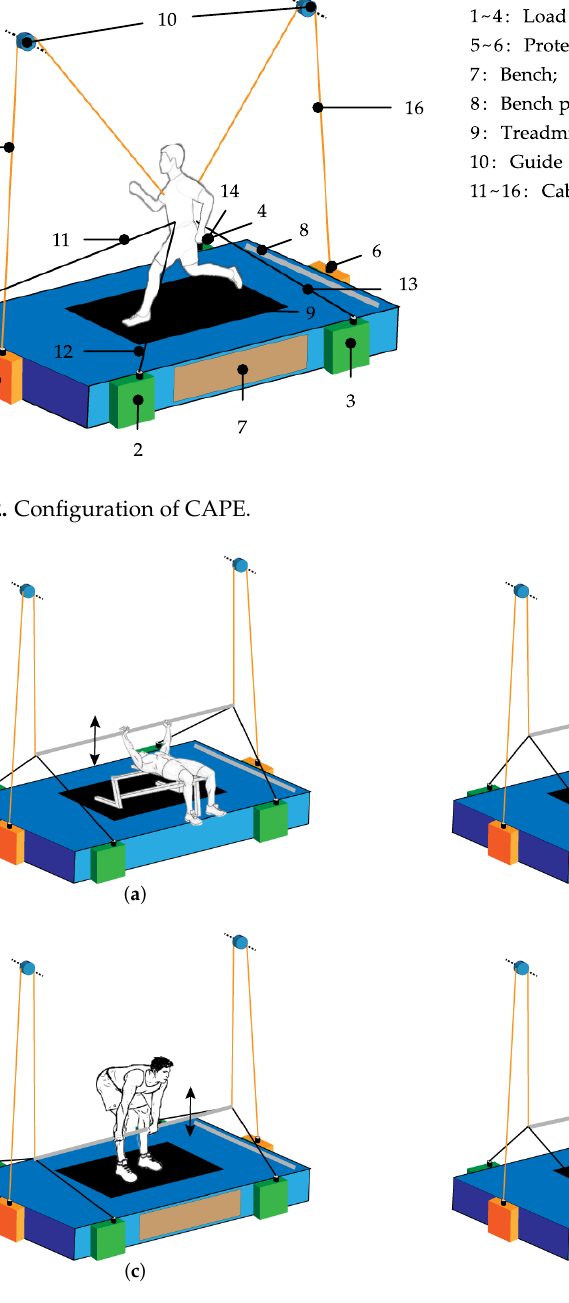
Figure 3. Exercise modes assisted by CAPE. ( a ) bench press; ( b ) deep squat; ( c ) deadlift; ( d ) heel